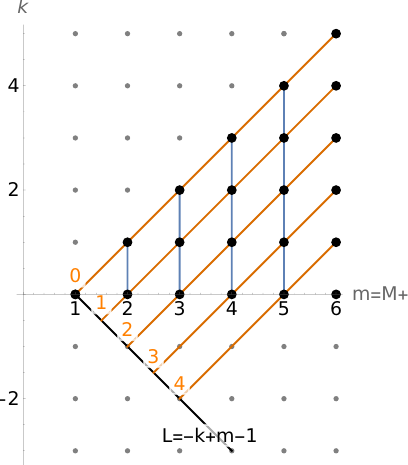
Figure 5 . The sum that defines the 2-form B runs over the black marked points in the lattice (lower wedge of first quadrant). In the original definition, we first sum over k (vertical blue lines) and then add up those. It is however convenient to change coordinates to ( L = − k + m − 1 , M = m − 1) , L ≥ 0 , M ≥ L , such that the summation runs first along the diagonals (orange lines with fixed L = 0 , 1 , 2 , . . . ) and in the final step we add up their